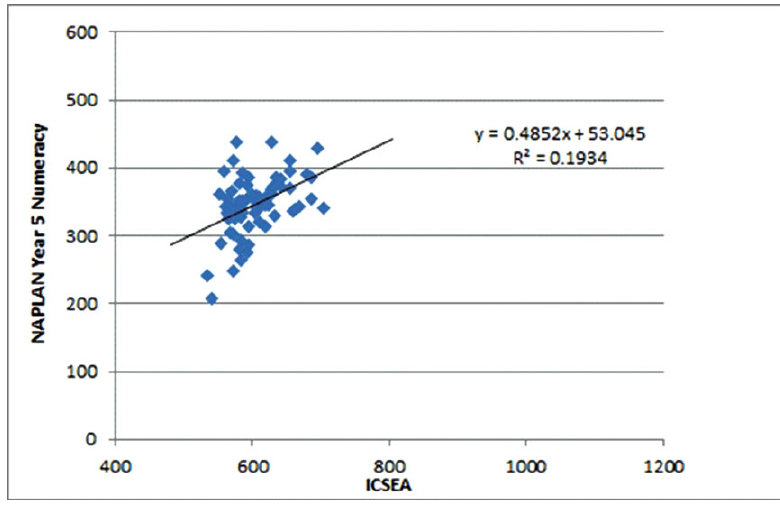
FIGURE 4 (Colour online) NAPLAN Year 5 Numeracy scores for very remote schools with greater than 80% Aboriginal and Torres Strait Islander students, by ICSEA, 2012 (n = 74).